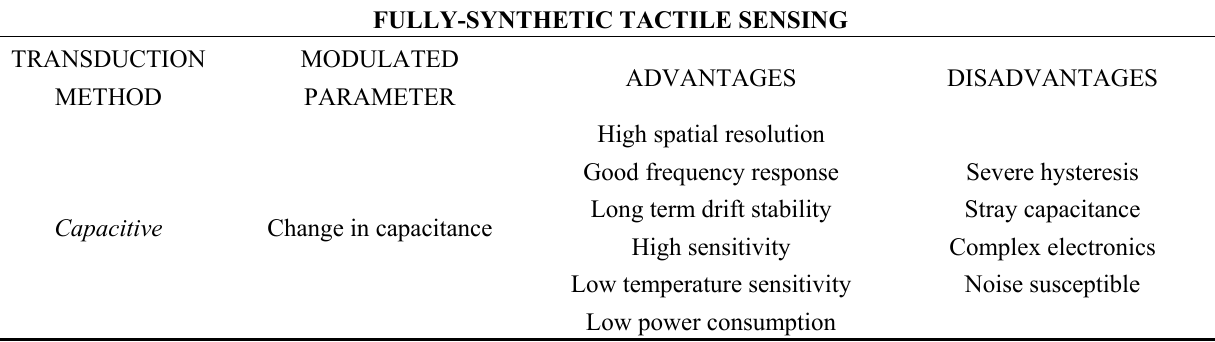
Table 2. Fully-synthetic tactile sensing: transduction methods, advantages and disadvantages (synthesis from